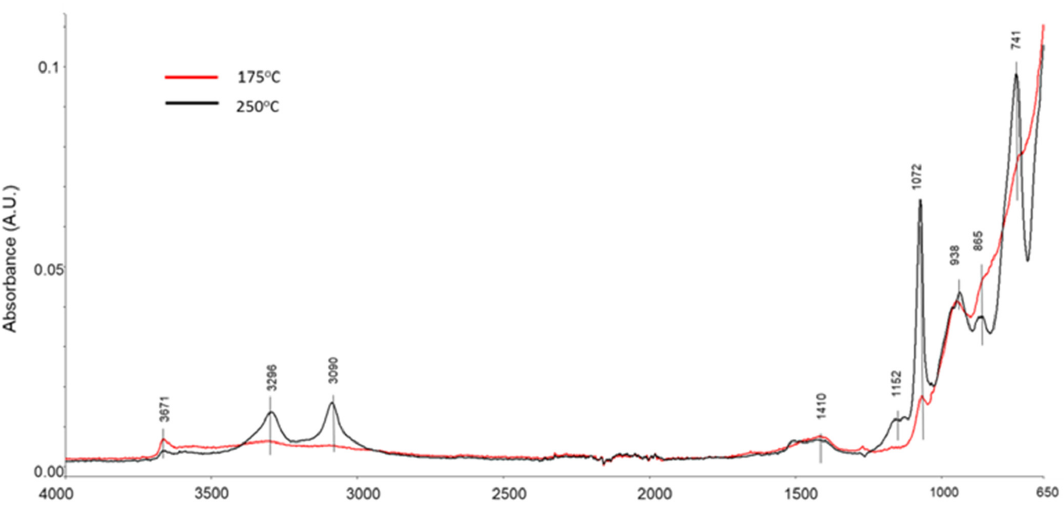
Figure 18. ATR-FTIR spectra of 175 and 250 °C autoclaved samples of